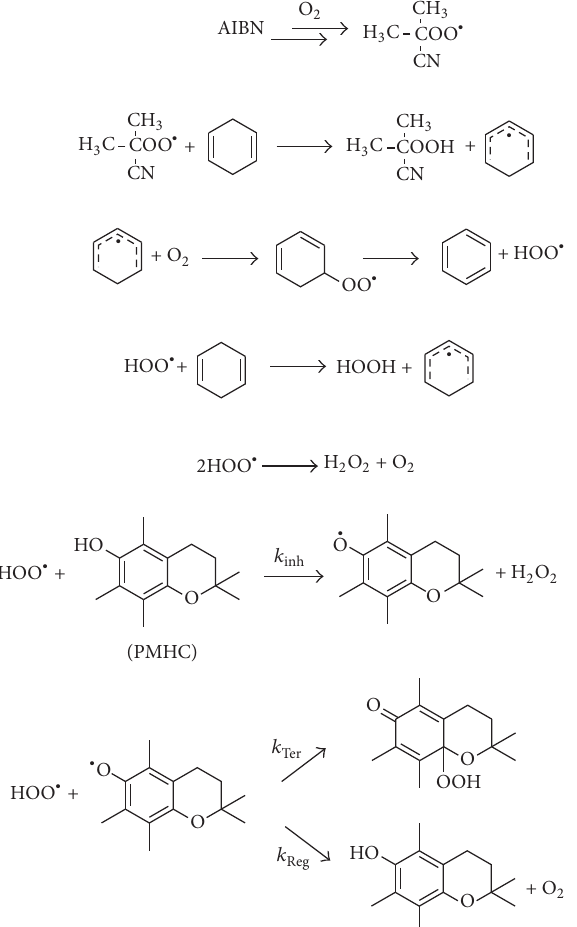
Scheme 4: Autoxidation of 1,4-cyclohexadiene inhibited by the analogue of 𝛼 -tocopherol